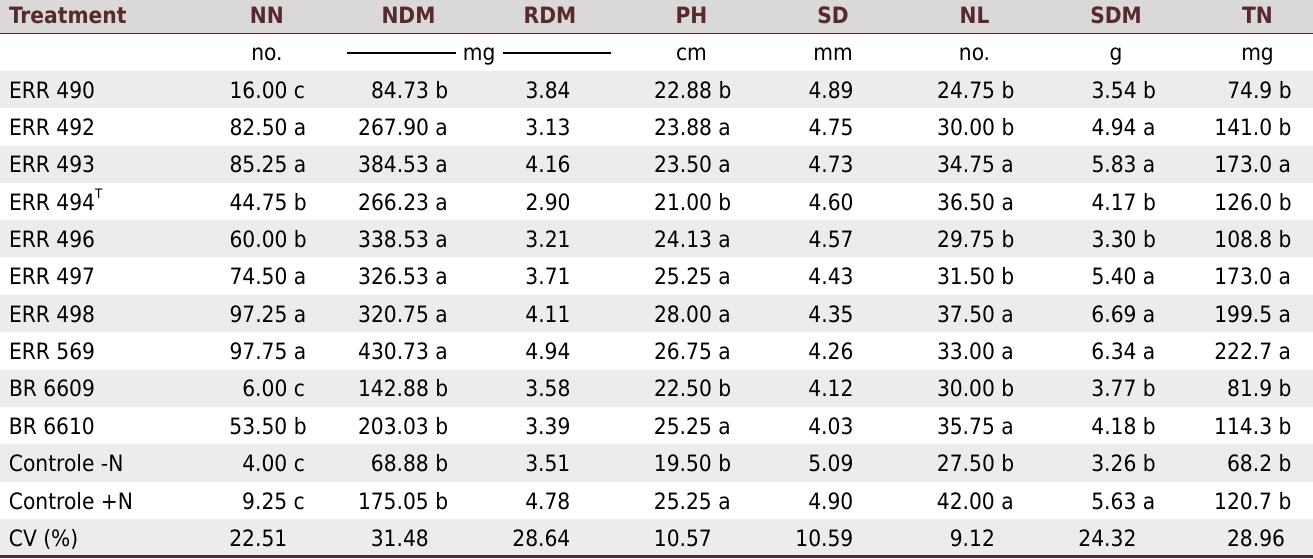
Table 3. Inga edulis Mart. response to inoculation with Bradyrhizobium ingae strains under nursery conditions in bags with non-sterile substrate for 100 days (Experiment 3) Treatment